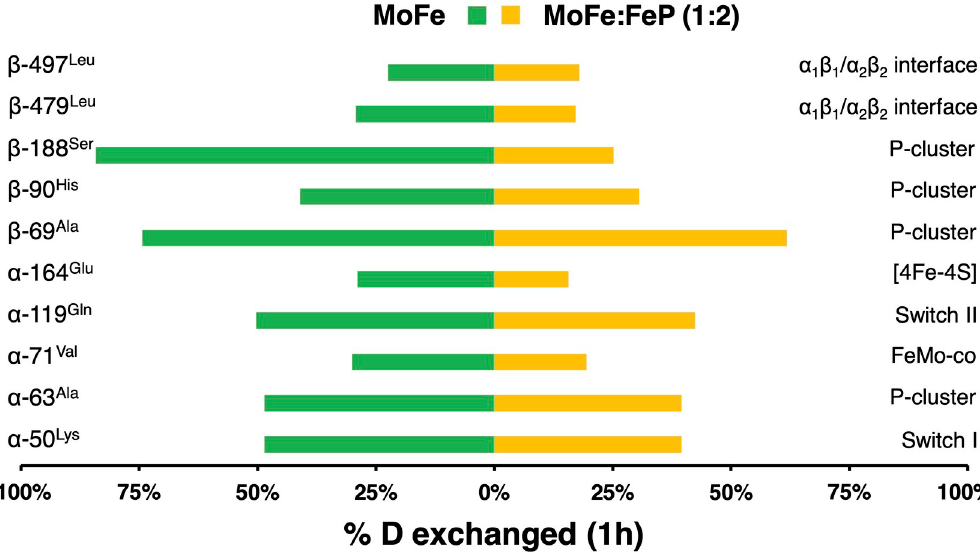
Fig 8. HDX Mass Spectrometry measured deuterium exchange in the MoFe protein alone and in the presence of the ATP-bound Fe protein. The percent deuterium uptake at 1 hour in selected regions of MoFe alone and in complex with Fe protein is shown as a histogram. Complete exchange was based on a 24-hour time